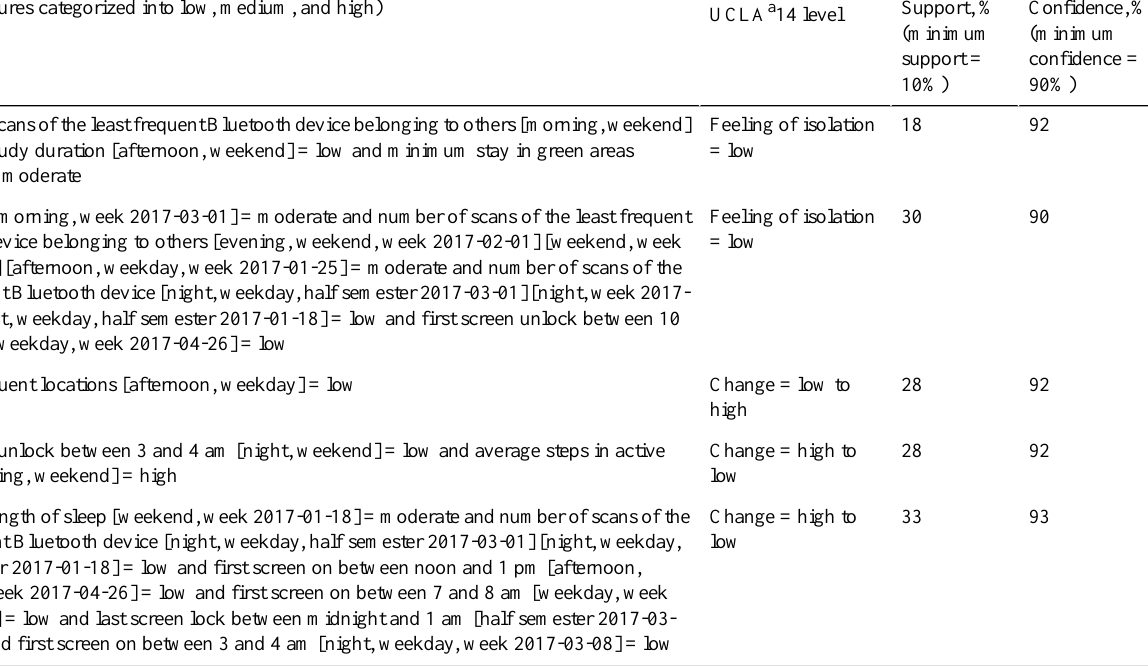
Table 7. Extracted behavioral patterns associated with the feeling of isolation.